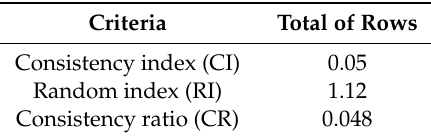
Table 19. Consistency